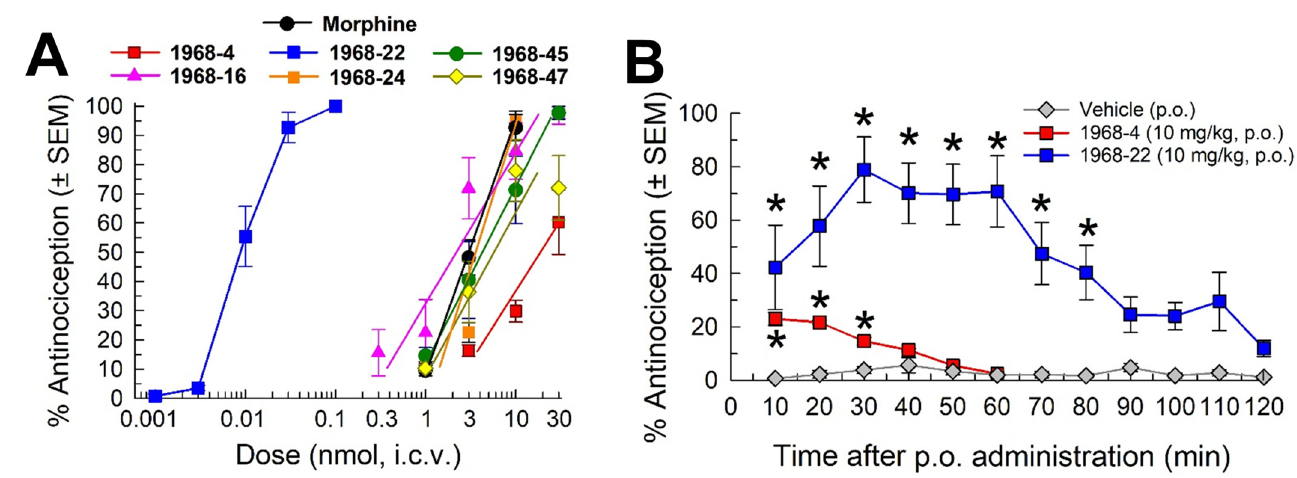
Figure 2. Antinociceptive activity of 1968 -series compounds in the 55 ◦ C warm-water tail-withdrawal assay. ( A ): Dose-dependent antinociception following i.c.v. administration of 1968 -series compounds in C57BL/6J mice. Morphine is included as positive control. All points represent antinociception at peak response, which occurred 20–30 min after administration. ( B ): Antinociceptive time course of vehicle (1:1:8) 1968-4 or 1968-22 following oral (p.o.) administration. Points represent average % antinociception ± SEM from eight mice (16 for 1 nmol dose of morphine) for each set presented. * p < 0.05 vs. vehicle at matching time point; Sidak’s post hoc test. Table 1. Summary of in vivo opioid antinociceptive activity of morphine and the 1968 -series compounds. ED 50 (and 95% Confidence Interval (C.I.))